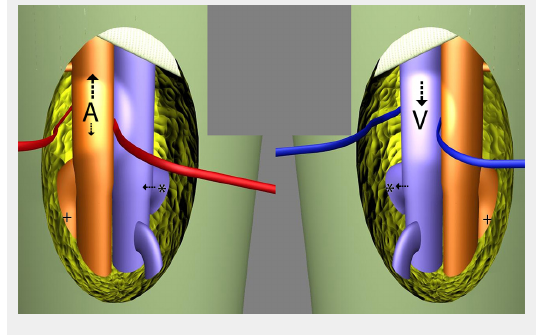
Schematic view of ipsilateral dual arterial cannulation and contralateral venous cannulation just caudal to the inguinal ligaments: systemic arterial cannulation (A) cephalad to the deep femoral artery (+), ipsilateral second arterial cannulation (D) for distal perfusion and contralateral venous cannulation (V) cephalad to the deep femoral vein (*). Collateral venous drainage is possible via the bilateral deep femoral veins (*) and the pelvic collaterals. The same holds true for the collateral flow via the bilateral deep femoral arteries (+). Although percutaneous cannulation on a routine basis is preferred, an open technique is displayed here for better identification of the femoral vessels and their